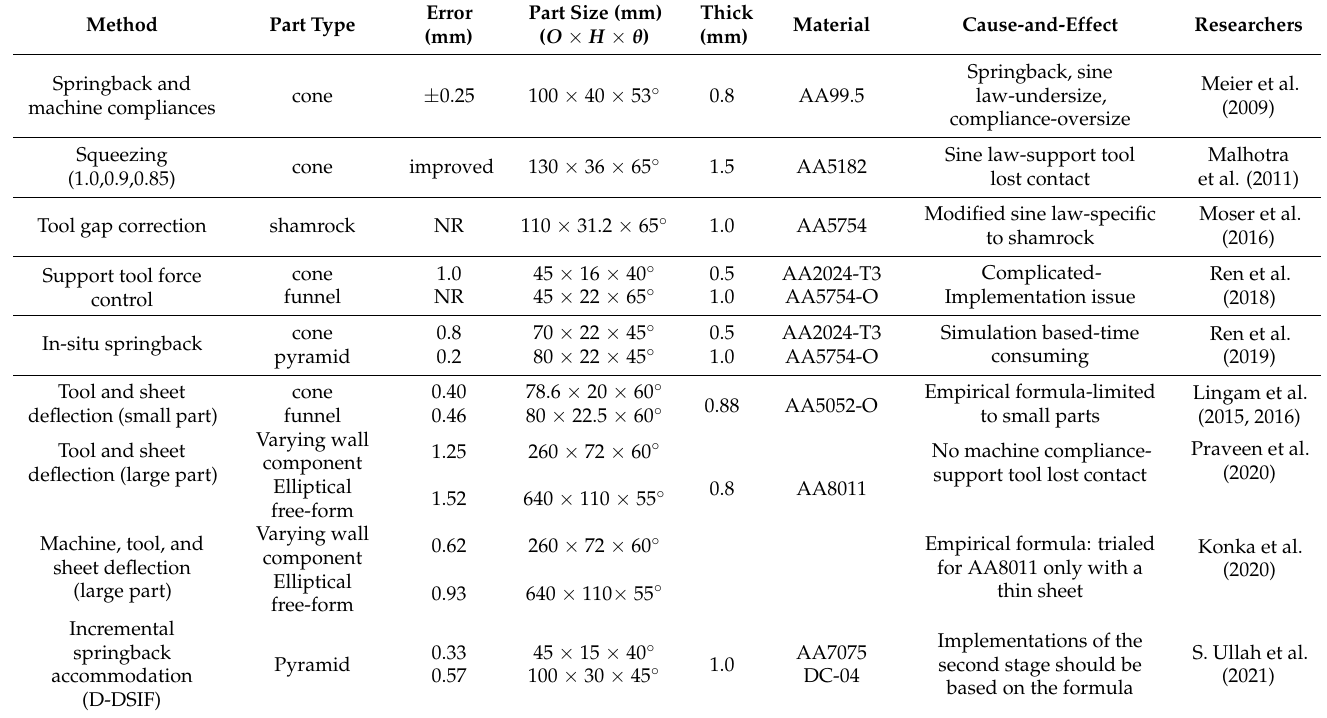
Table 1. Accuracy improvements based on tool-path compensation.